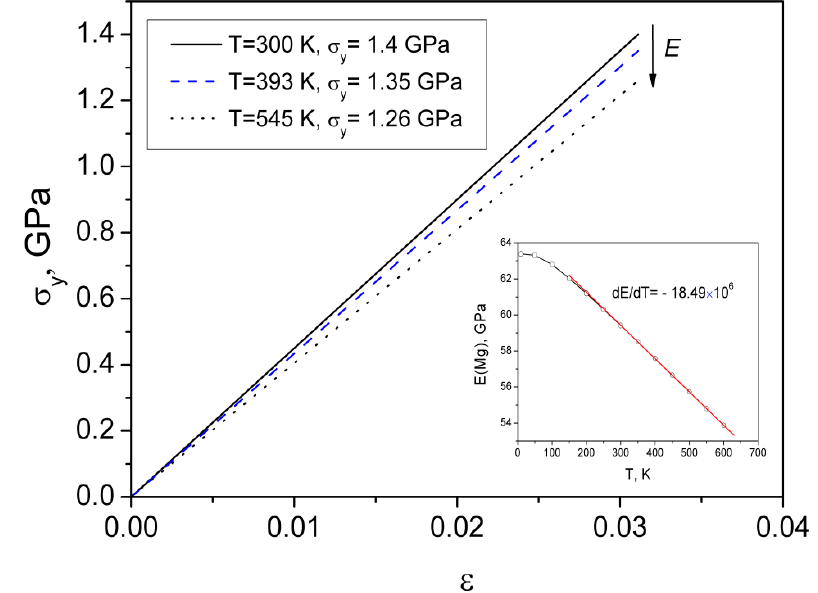
Figure 5. Temperature dependence of the Elastic limit/Yield stress, σ inset shows the temperature dependence of the Young modulus of Mg, reproduced using Equation (3) and the parameters from Varshni [37]; the slope of the linear part of the curve is calculated from the regression